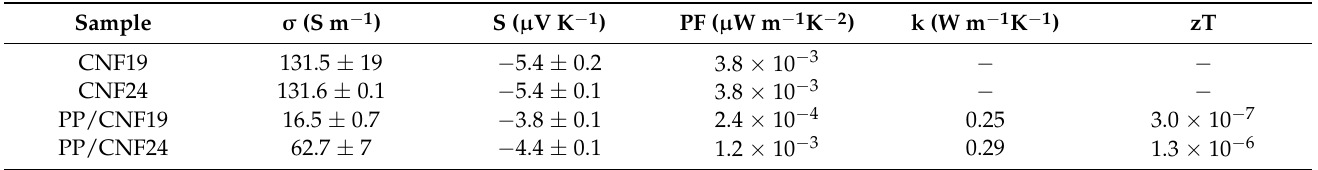
Table 4. Electrical conductivity σ , Seebeck coefficient S, power factor PF, thermal conductivity k, and figure of merit zT of CNFs and PP/CNF composites at 40 ◦ C. (Data for CNF19 and PP/CNF19 taken with permission from ref. [15]. Data of CNF 24 taken with permission from ref.